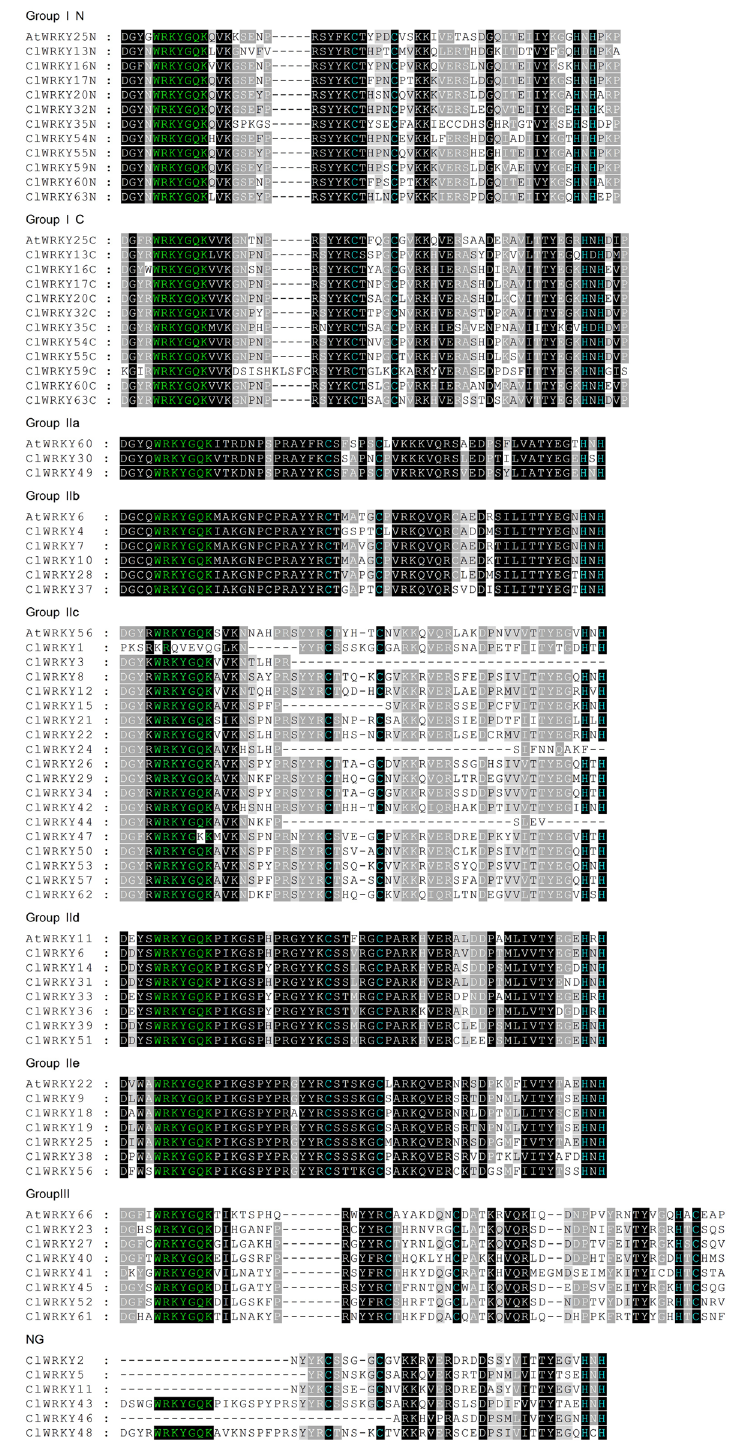
Fig 1. Alignment of 63 ClWRKY and 7 AtWRKY domain amino acid sequences. Alignment was accomplished using MUSCLE. ‘N’ and ‘C’ indicate the N-terminal and C-terminal WRKY domain of a specific WRKY protein, respectively. The amino acids forming the zinc-finger motif are highlighted in blue, the conserved WRKY amino acid domains is highlighted in green.